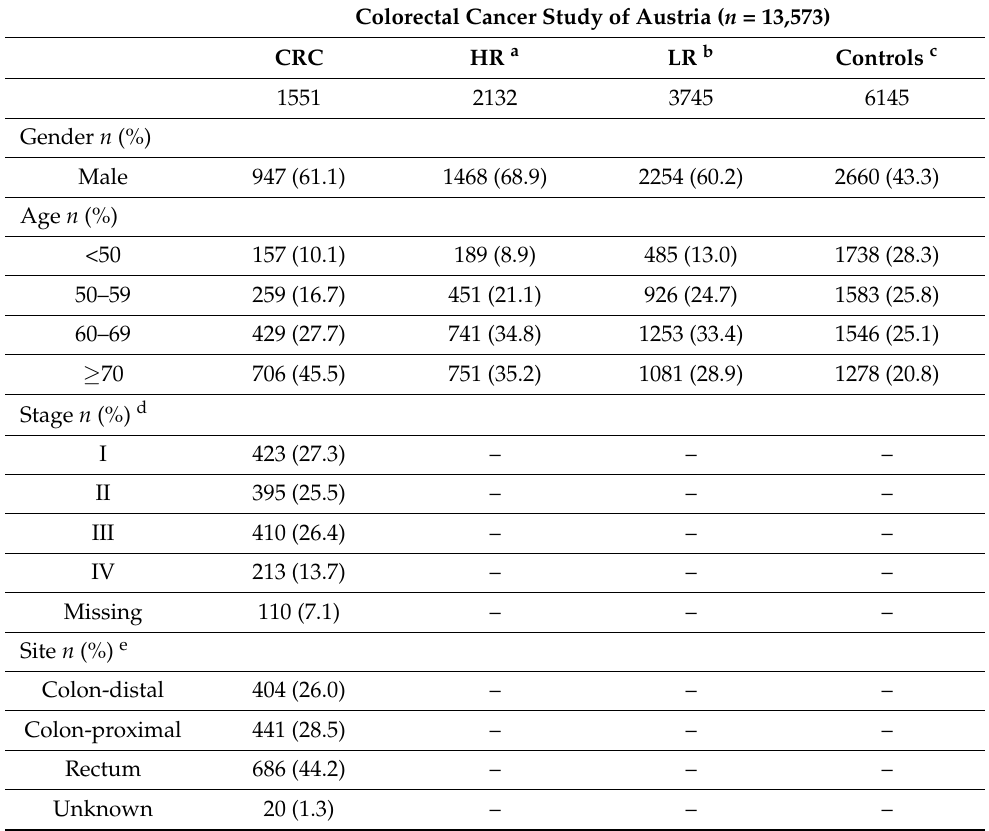
Table 1. Demographic and clinical characteristics of CORSA participants (as of May